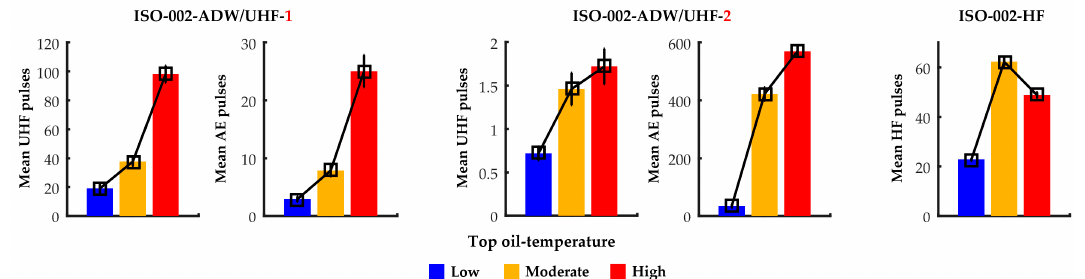
Figure 34. Estimated marginal means of PD pulses.